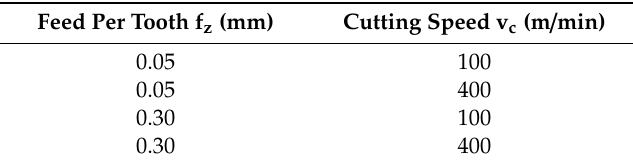
Figure 4. Schematic representation of the cutting edge for the 2D FE model and its parameters. Table 1. Cutting parameters in the FE simulations of peripheral